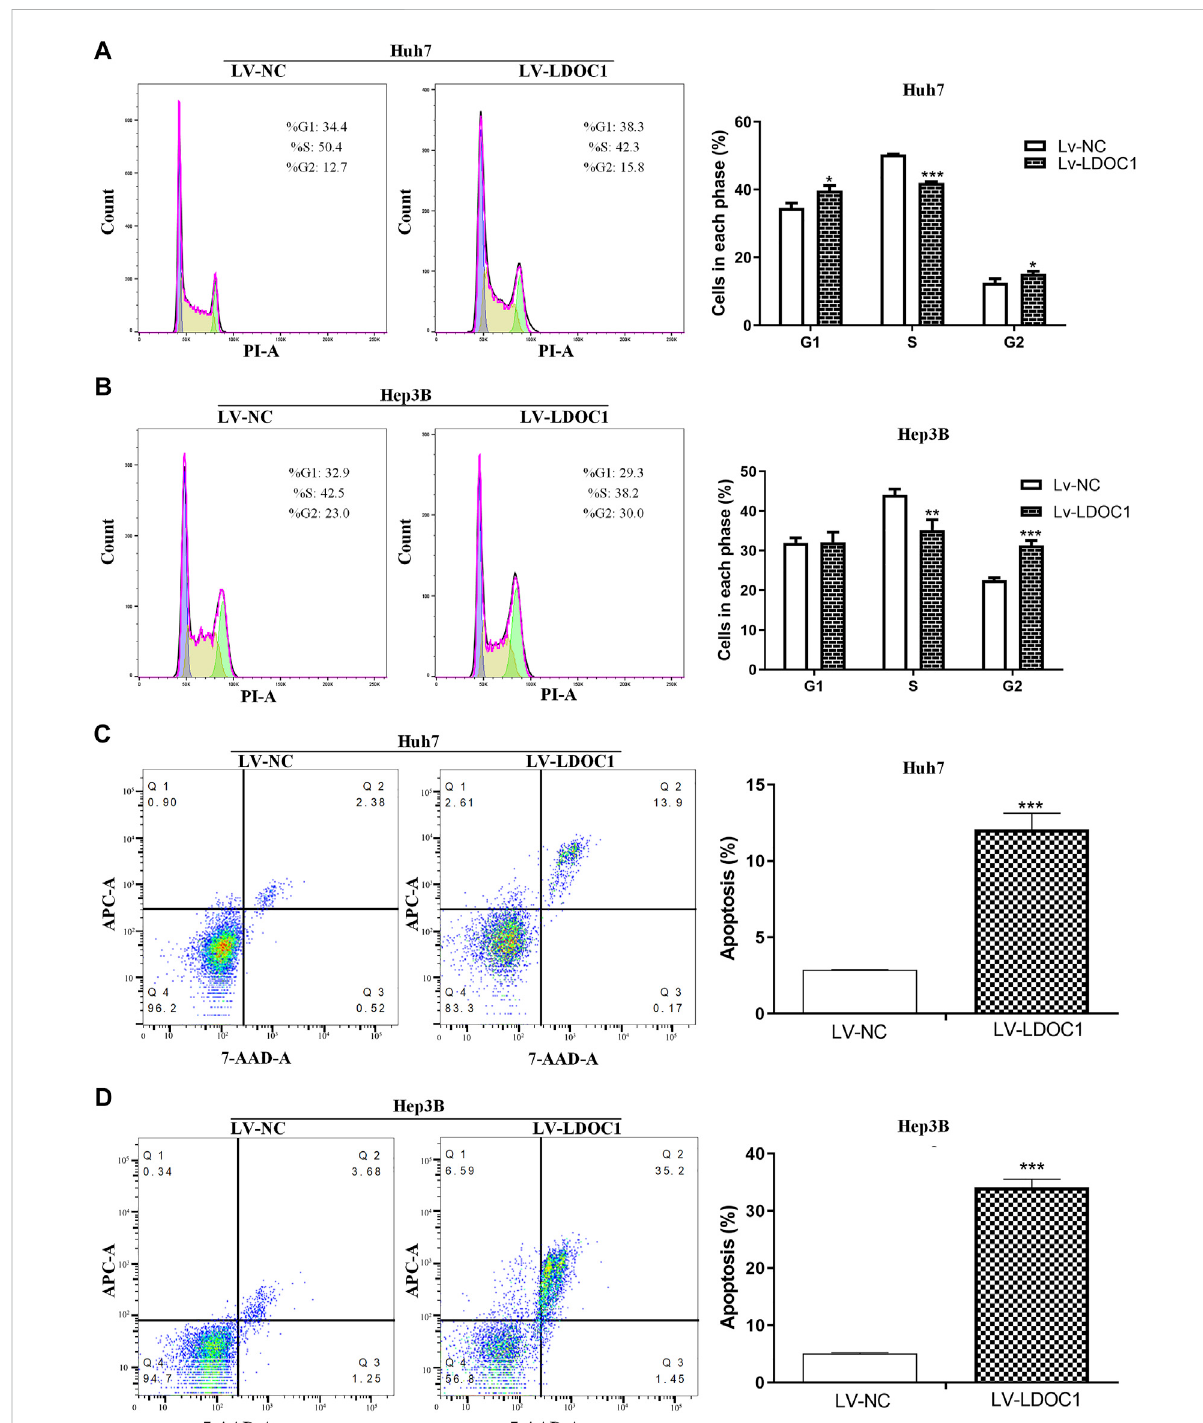
FIGURE 7 Cell cycle and apoptosis assays for Huh7 and Hep3B cell lines after LDOC1 over-expressing. From the cell-cycle distributions, (A) Huh7 (Lv- LDOC1) cells were signi fi cantly arrested in the G1 and G2 phases, while (B) Hep3B (Lv-LDOC1) cells were signi fi cantly arrested in the G2 phase. The apoptosis rates for (C) Huh7 and (D) Hep3B cell lines in the Lv-LDOC1 and Lv-NC groups. *, p < 0.05; **, p < 0.01; ***, p <